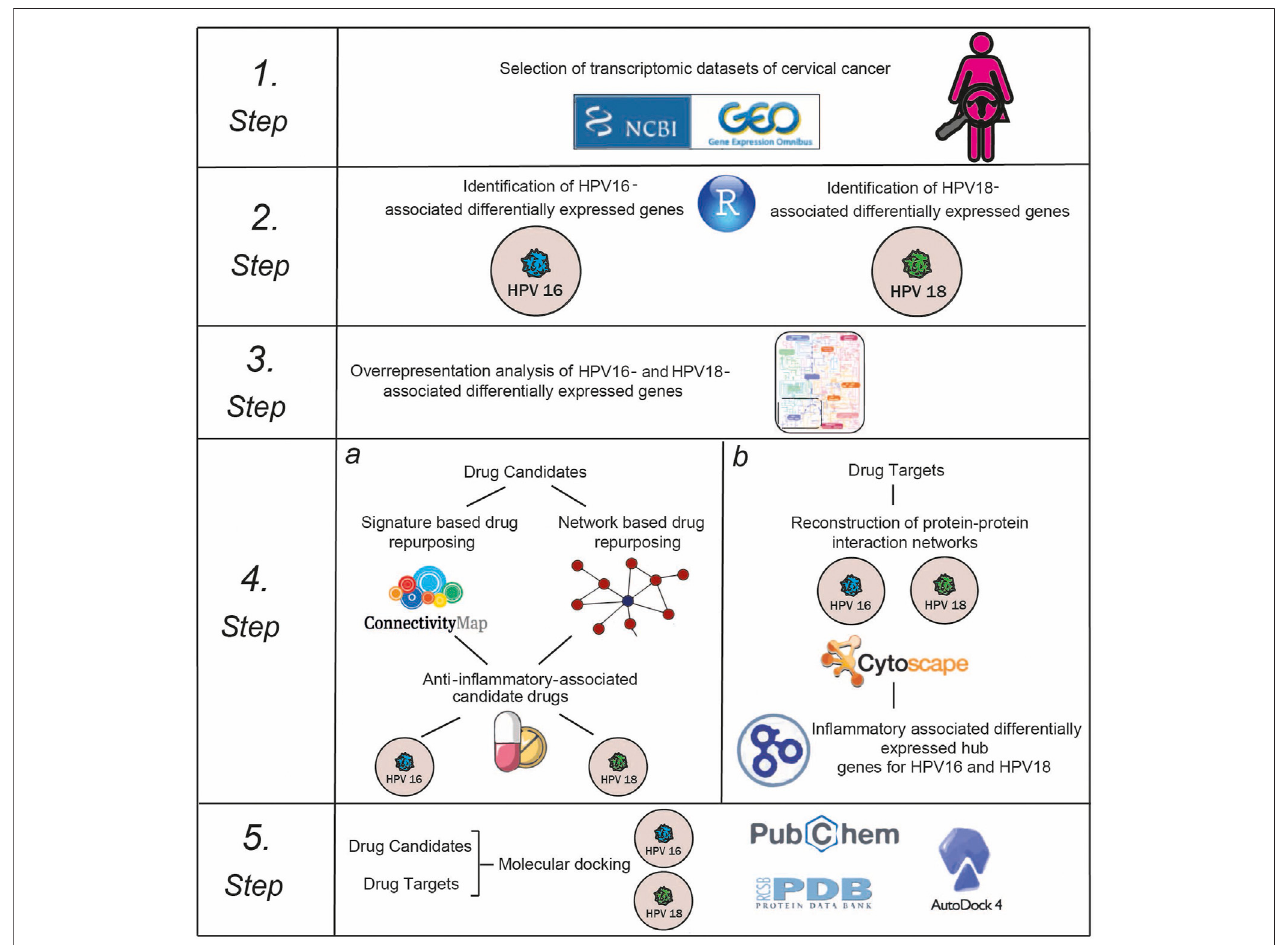
FIGURE 1 | The multi-stage computational approach was employed in the